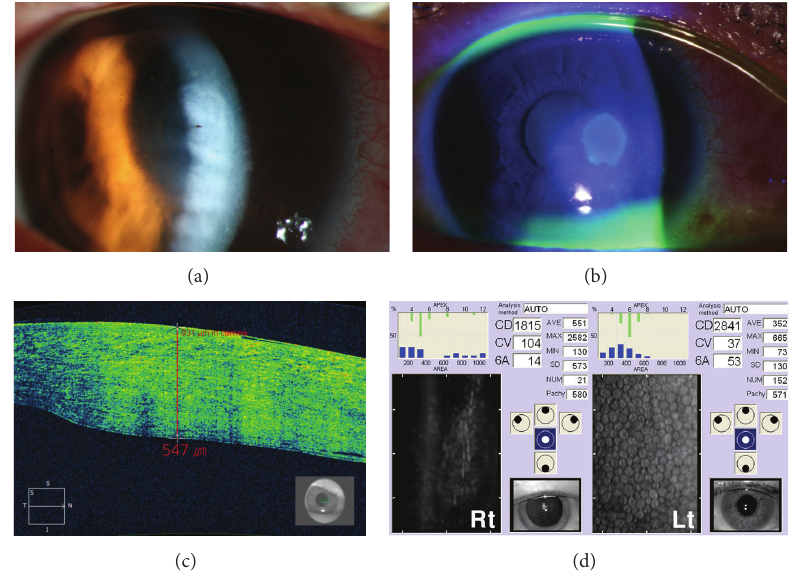
Figure 1: (a) Anterior segment photography depicting severe corneal edema with stinger in deep stroma. (b) Anterior segment photography showing round epithelial defect. (c) Anterior segment optical coherence tomography demonstrating severe corneal swelling and markedly increased corneal thickness (931 𝜇 m) in the affected area. (d) Specular microscopy revealing substantially decreased endothelial cell density in the right eye compared to the left eye.